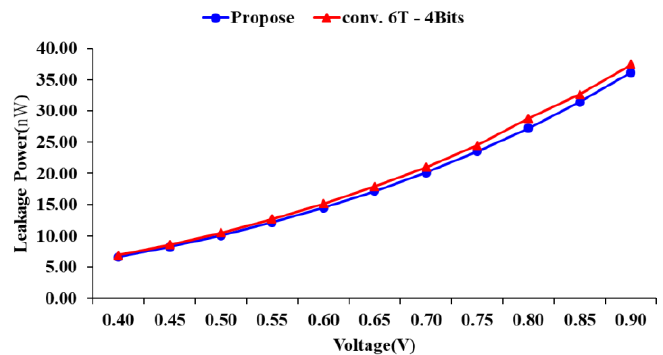
Figure 9. Comparison of leakage power at different operating voltages.